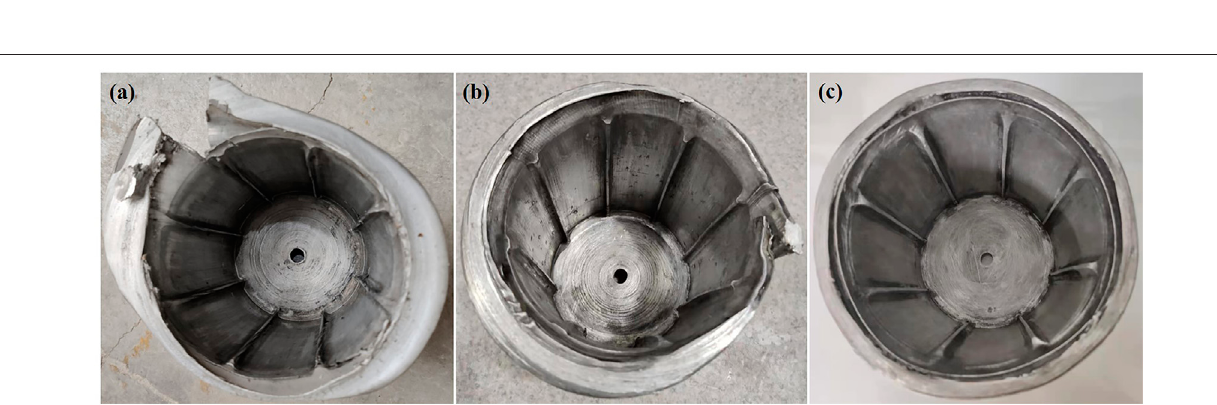
FIGURE 3 | CSE forming results. (A) 1#, (B) 2#, (C) 3#.